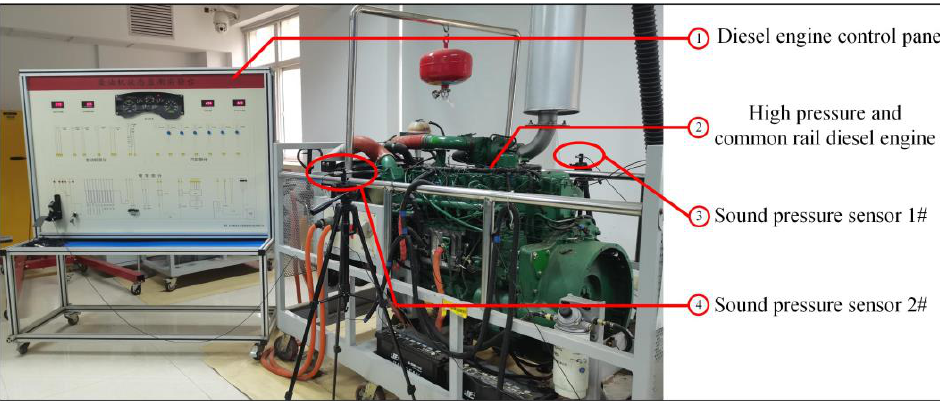
Figure 6. Diesel engine condition monitoring test bench.